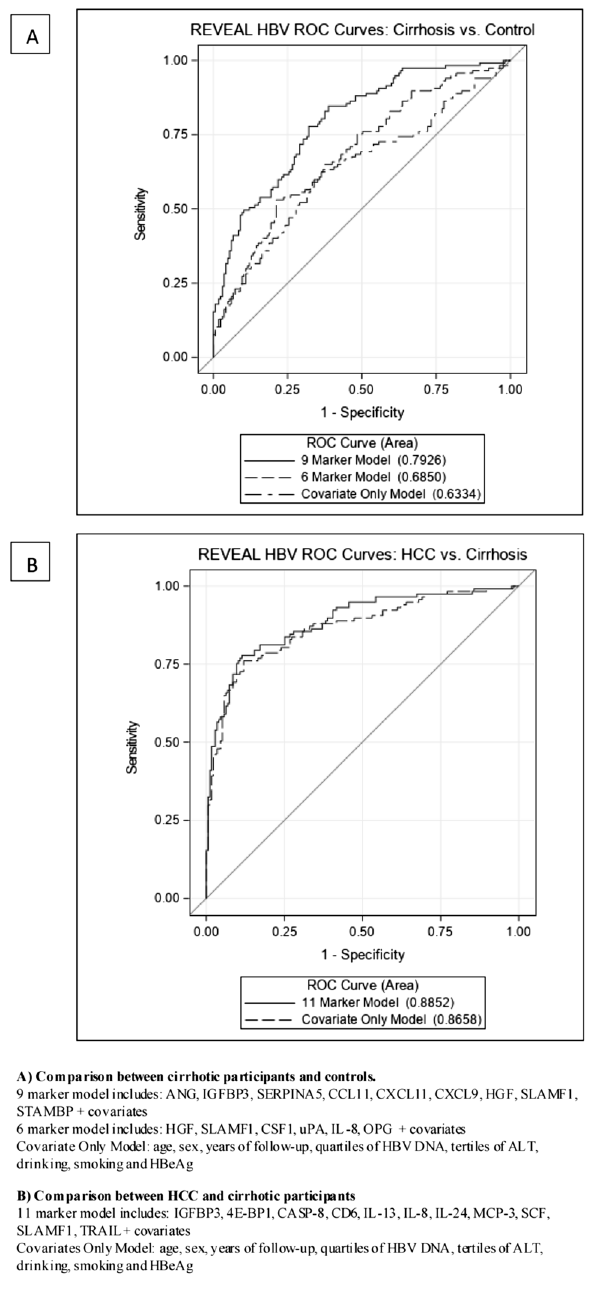
Figure 1. Receiver operating characteristic (ROC) curves comparing predictive